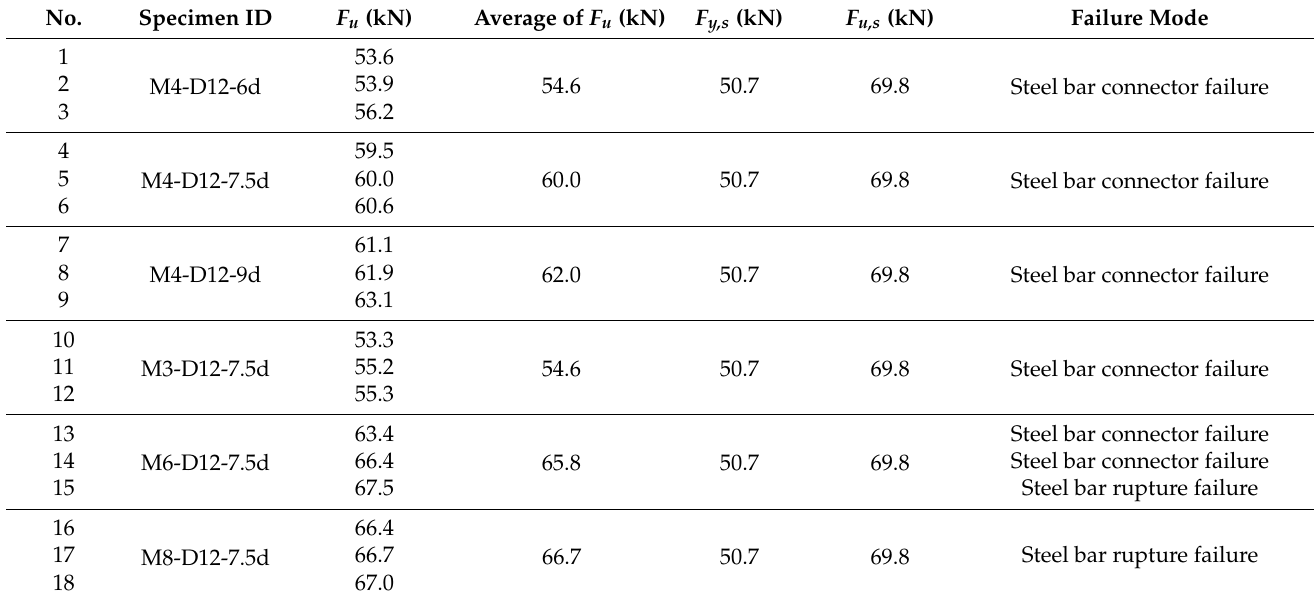
Table 4. Experimental data of bearing